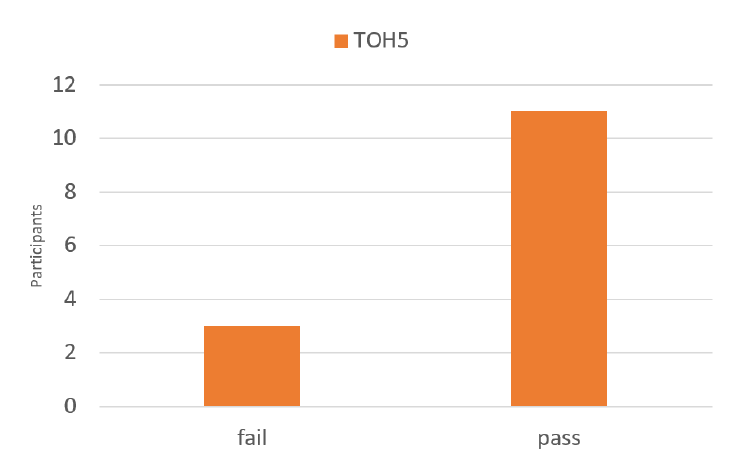
Figure 9. Histogram of fail and pass for tasks